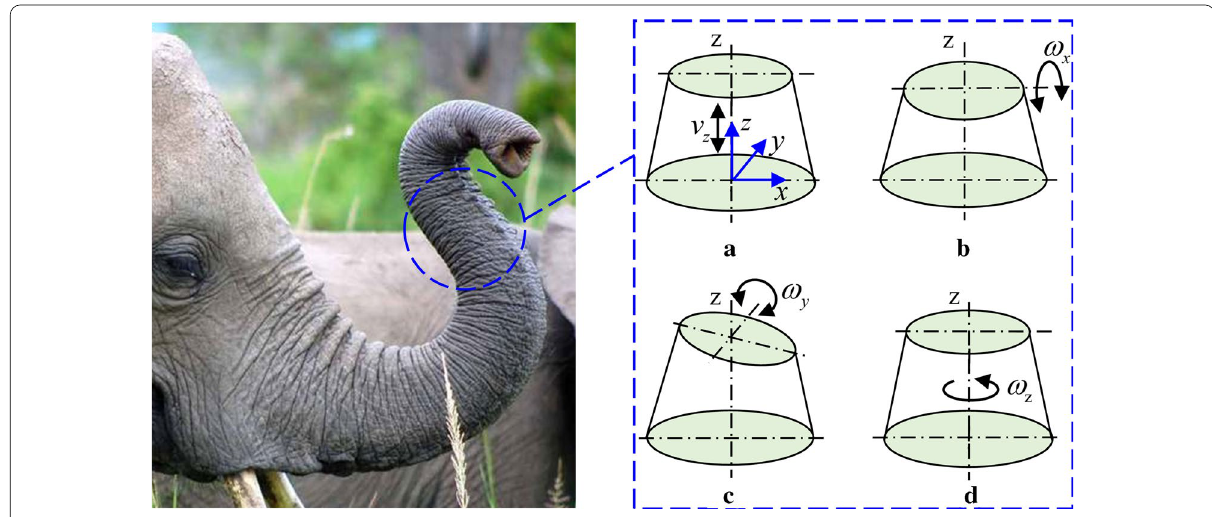
Figure 1 Posture of elephant’s trunk